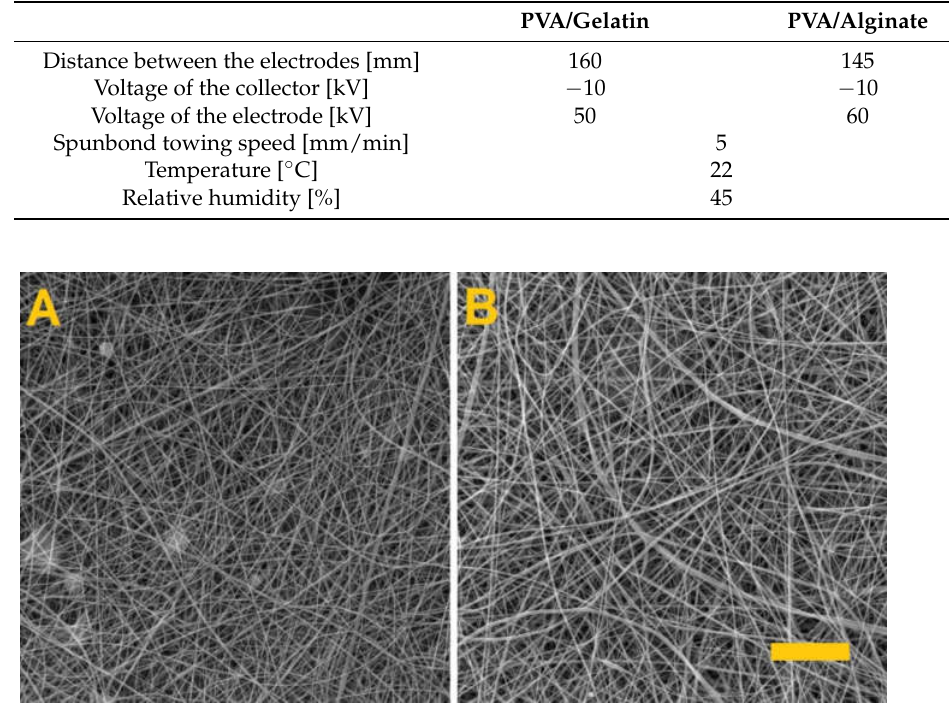
Figure 1. Morphology of the produced fibrous layers. ( A ) PVA/gelatin, ( B ) PVA/alginate. Scale 10 μm. Table 2. Parameters of the produced fiber layers. Table 2. Parameters of the produced fiber